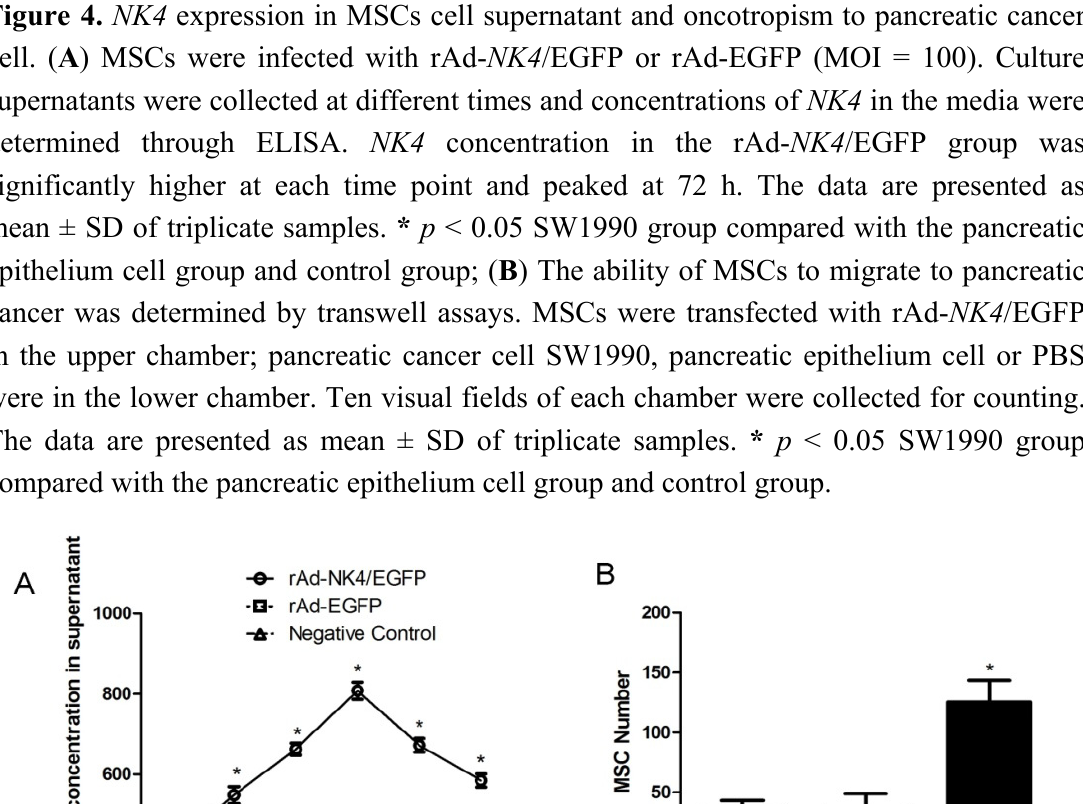
Figure 4. NK4 expression in MSCs cell supernatant and oncotropism to pancreatic cancer cell. ( A ) MSCs were infected with rAd- NK4 /EGFP or rAd-EGFP (MOI = 100).